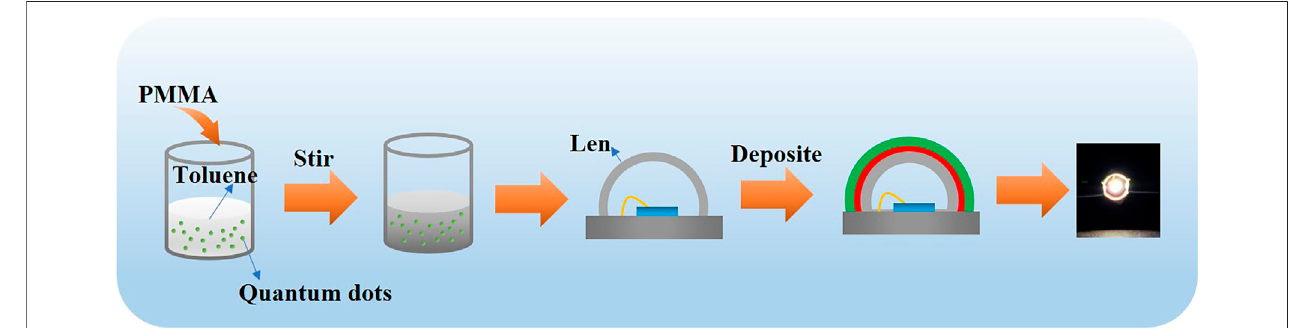
FIGURE 4 | Fabrication process of the CdZnSeS/ZnSeS QD WLED device. QD, quantum dot; WLED, white light-emitting diode.